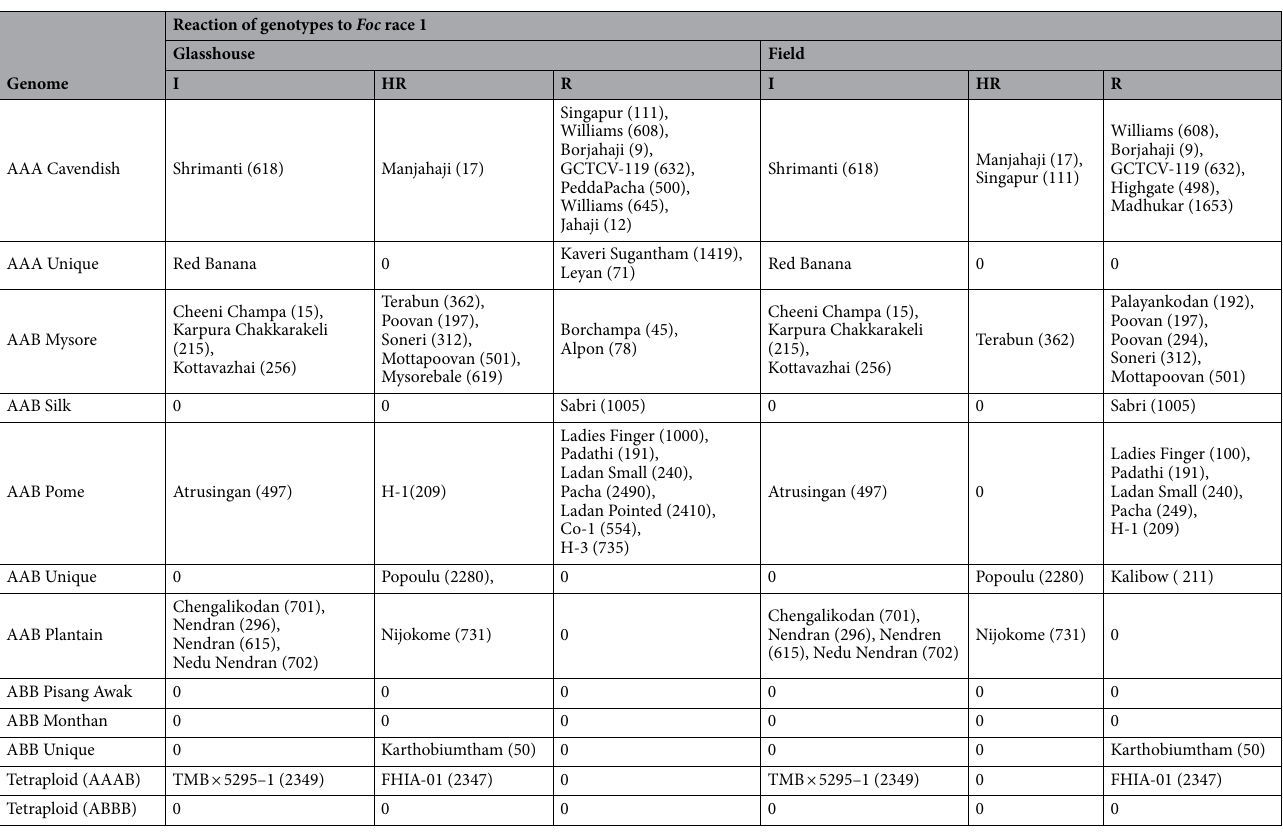
Table 3. Triploid and tetraploid genotypes resistant to Foc race 1 (VCG 0124) under glasshouse and field conditions. I-Immune; HR-Highly resistant;